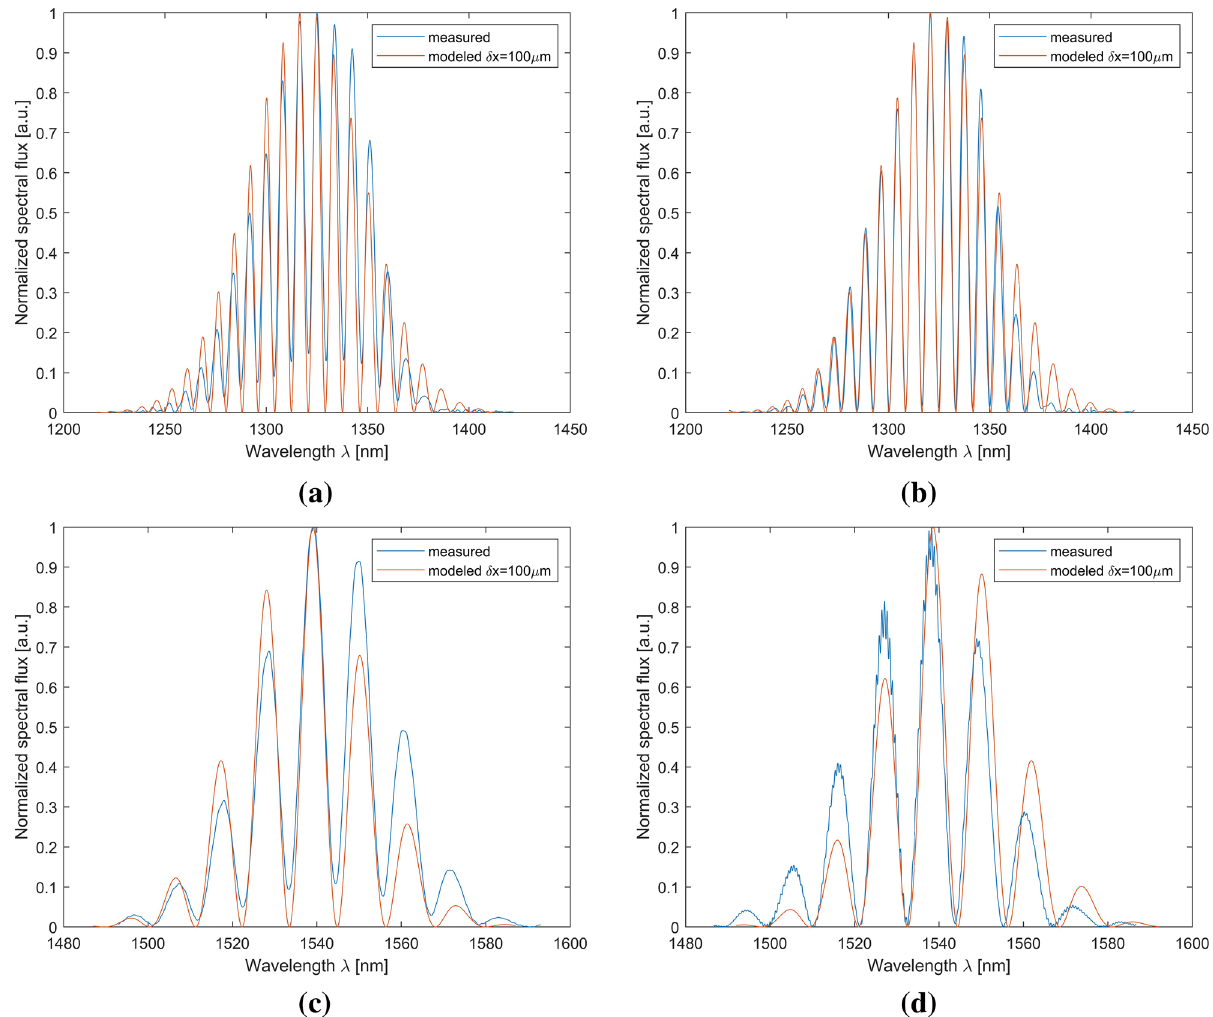
Figure 6. Comparison of the theoretical optical spectra with the measurement results ( a ) for a silver mirror at a wavelength of 1310 nm; ( b ) for an SiN thin film at a wavelength of 1310 nm; ( c ) for a silver mirror at a wavelength of 1550 nm; ( d ) for a SiN thin film at a wavelength of 1550 nm. The cavity length was set to 100 distance between the peaks are shown in each plot. For SiN on the left, the smallest distributions were observed for widths from 110 to 200 μm. The differences between the series of measurements must not exceed 1 nm. The best measurement repeatability was obtained for the width of 130 μm. The difference between the highest and the lowest value in the series was about 0.9 nm. On the right, repeatability with a data spread of 1 nm was observed for a width of 110 to 200 µm. The most reproducible measurements were obtained for the width of 190 μm. The difference between the maximum and minimum measurement values was 0.2 nm. The silver data distribution on the left shows a data spread of less than 1 nm for widths from 90 µm. The best reproducibility was observed for the width of 140 μm. The difference between the highest and the lowest measured value is 0.3 nm. On the right, repeatability with a spread of less than 1 nm was observed for widths from 80 to 200 µm. The best repeatability was obtained for the widths of 180 and 200 μm. The data distribution for these widths did not exceed 0.2 nm. Differences in the distribution of data for SiN and silver were observed. The data spread is greater for SiN in the range from 20 to 110 μm. Most likely, it is the fault of an under-regulated micromechanical screw. For widths above 110 μm, both materials have a data spread lower than 1 nm. The differences between the SiN distribution and the silver distribution in this range differ by tenths of nm. From Table 3 it can be seen that the greatest differences between the model and the mean of the data were observed for the range of 20–70 μm for silver and for the range from 20 μm to about 90 μm for SiN. The silver closest to the model was in the range from 70 to 200, and SiN in the range from 140 to 200 μm. For both materials at a wavelength of 1550 nm, similar values of the tested parameters were observed. Fitting to the model at a difference of 1 nm between the mean and the model was observed for SiN from 80 μm, and for silver from 70 μm. Measurement repeatability with 1 nm data spread for SiN was observed from 110 μm, and for silver from 90 μm. For both materials, the best data spread was 0.2 nm.